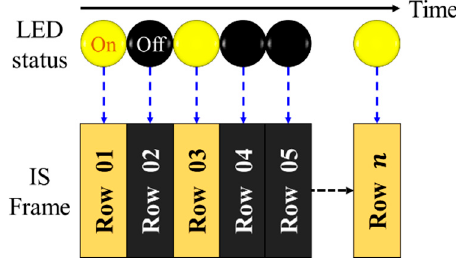
Figure 10. RS mechanism on image sensor for data capture.